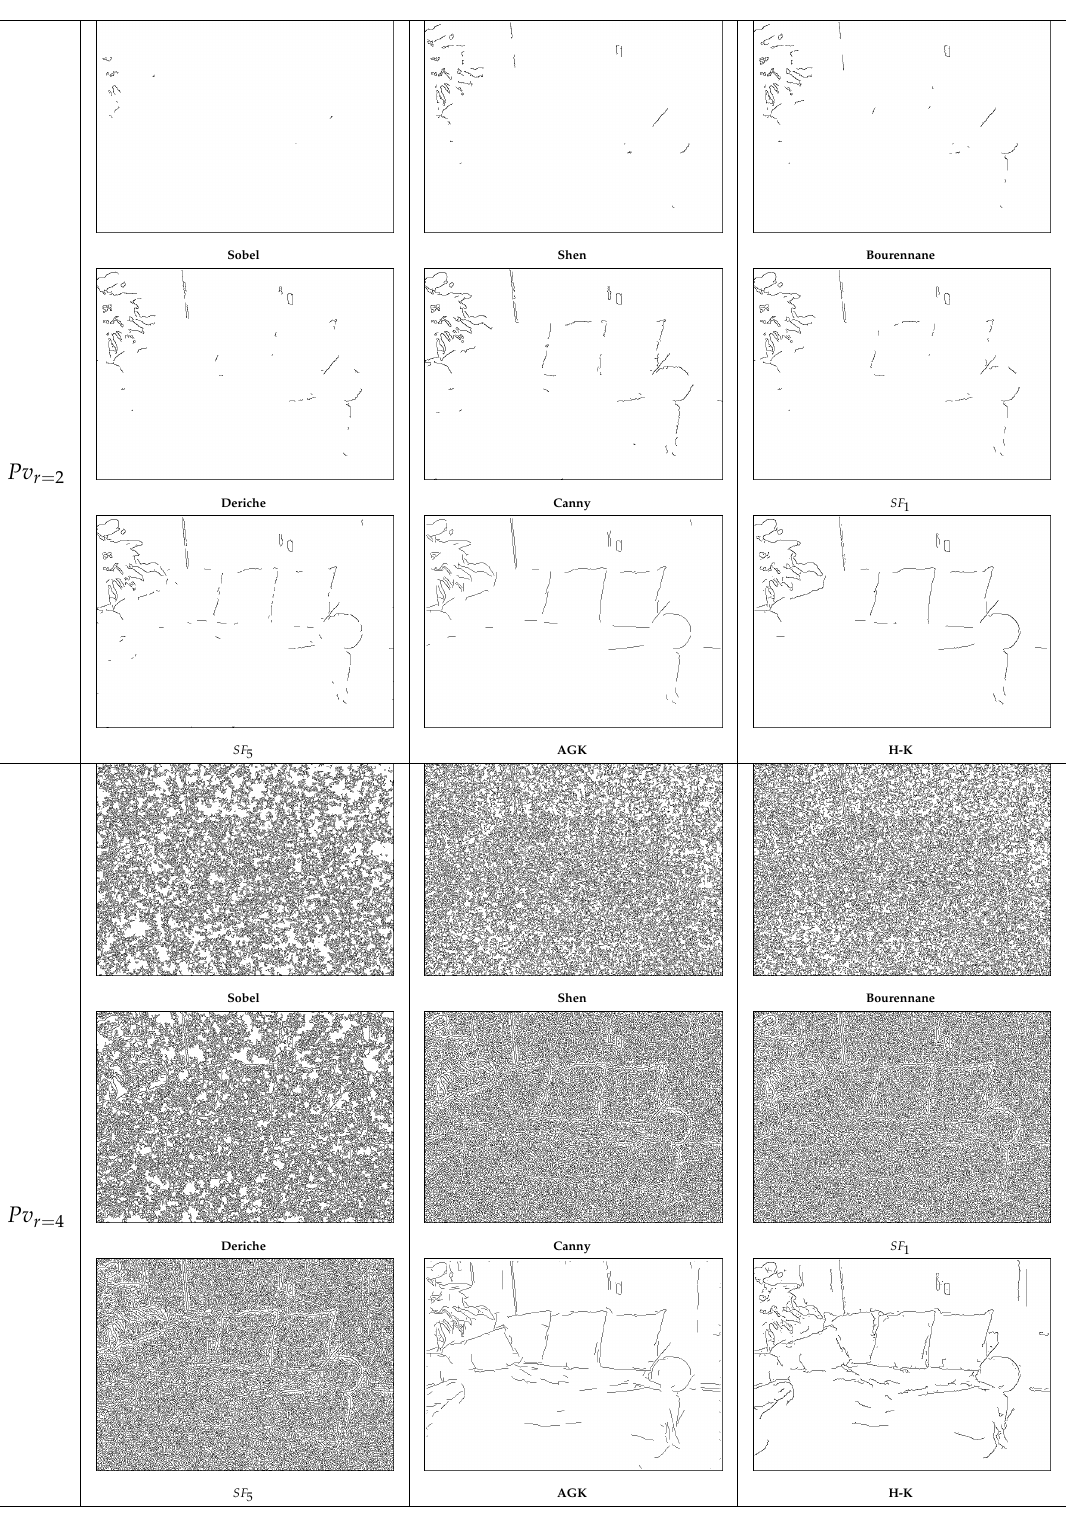
Figure 24. Ideal segmentations for several edge detectors on image 109, PSNR = 14